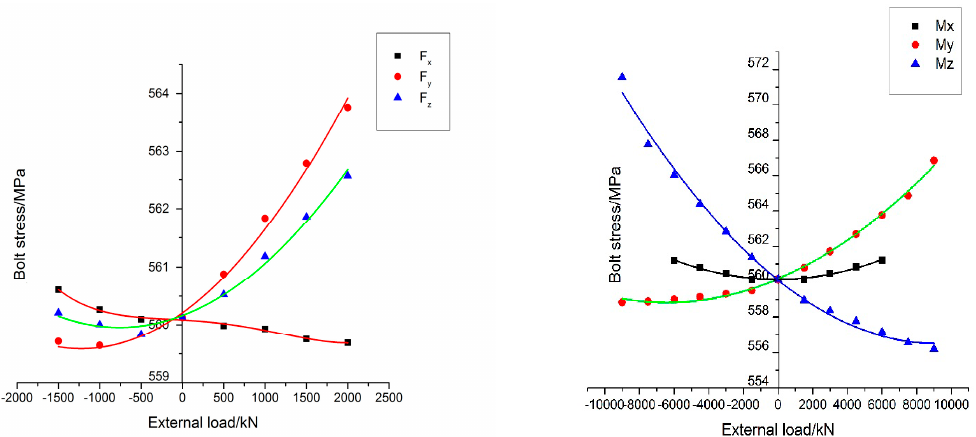
Figure 9. ( a ) The relationship between the force components and bolt stress; ( b ) The relationship between the moment components and bolt